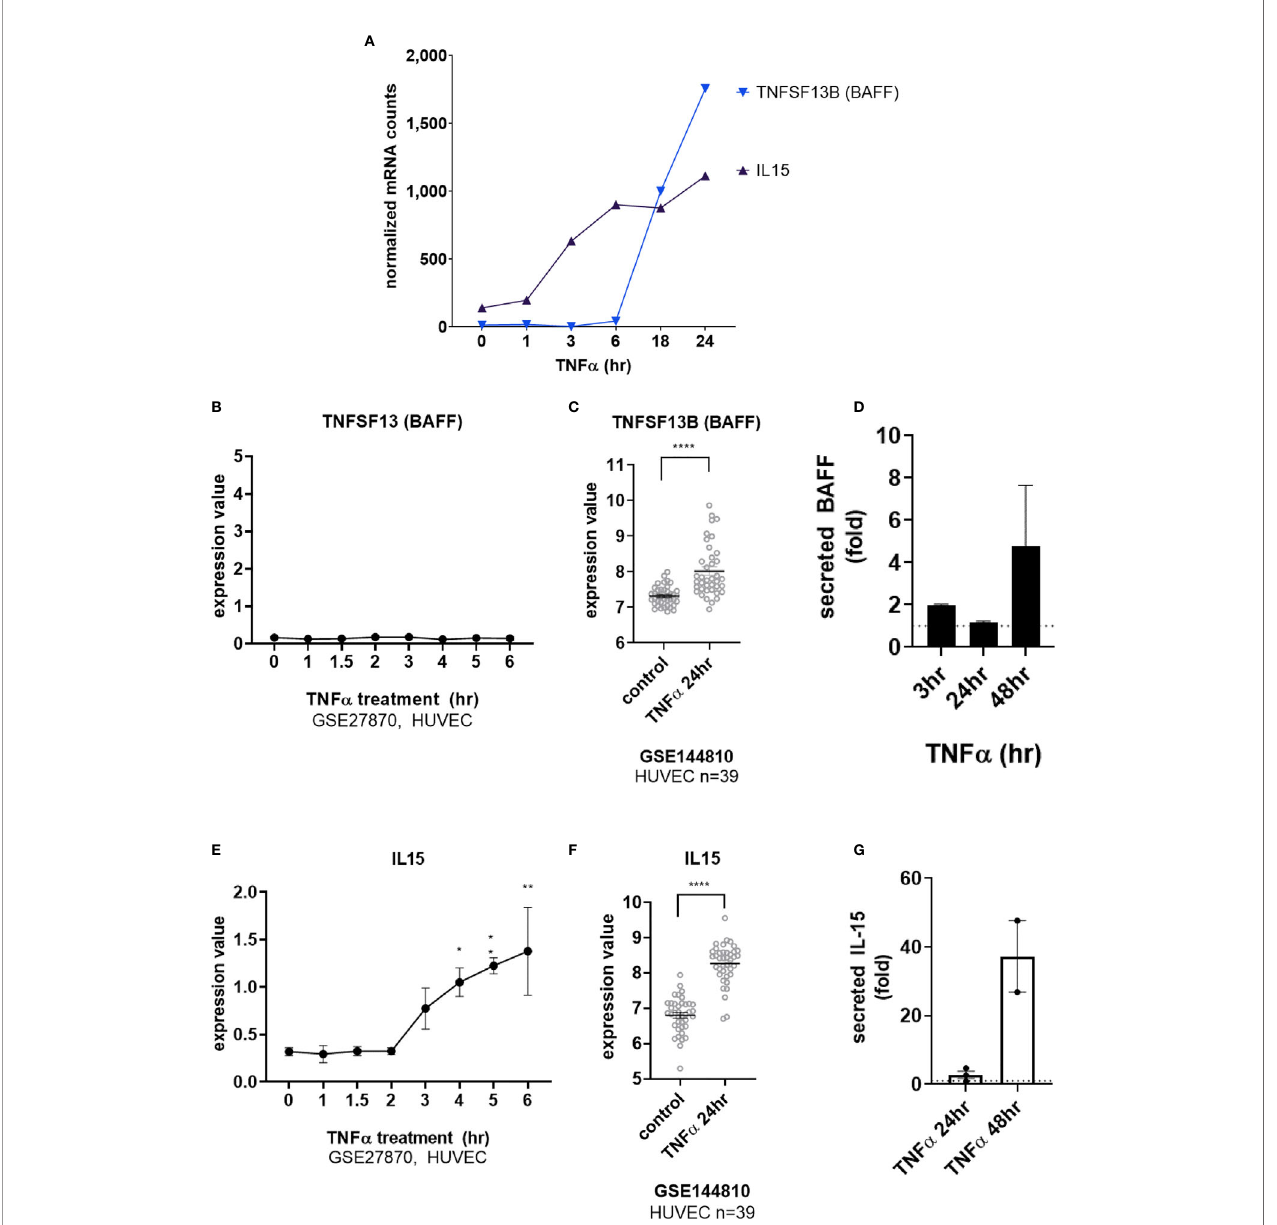
FIGURE 4 | TNF a induces endothelial expression of cytokines IL-15 and BAFF/BLyS. (A) HMEC-1 endothelial cells were stimulated with TNF a (20ng/mL) for 1hr, 3hr, 6hr, 18hr or 24hr. Time course of TNF a late phase induced cytokine mRNA for TNFSF13B and IL15 a in HMEC-1. One representative experiment is shown. Results are presented as absolute number of normalized mRNA counts for each gene, normalized to housekeeping controls. (B) Expression values of TNFSF13 from GSE27870 are plotted, for HUVEC stimulated with TNF a for 1hr, 1.5hr, 2hr, 3hr, 4hr, 5hr and 6hr. Values at each time point were compared to baseline (0hr) by One way ANOVA followed by uncorrected Fisher ’ s LSD t test. Results are shown as mean ± SEM (n=3). (C) Expression values of TNFSF13B from GSE144810 are plotted, comparing HUVEC (n=39) left untreated or stimulated with TNF a for 24hr. Value distributions were compared by unpaired t test. Results are presented with each measured value, and the line at the median. ****p < 0.0001. (D) Primary human aortic endothelial cells (n=4 HAEC donors) were stimulated with TNF a for 3hr, 24hr or 48hr. Supernatants were collected and secreted BAFF protein was measured by ELISA. Results are presented as the fold increase in secreted cytokine compared with conditioned medium from untreated endothelial cells, mean ± SEM. (E) Expression values of IL15 from GSE27870 are plotted, for HUVEC stimulated with TNF a for 1hr, 1.5hr, 2hr, 3hr, 4hr, 5hr and 6hr. Values at each time point were compared to baseline (0hr) by One way ANOVA followed by uncorrected Fisher ’ s LSD t test. *p < 0.05; **p < 0.01. Results are shown as mean ± SEM (n=3). (F) Expression values of IL15 from GSE144810 are plotted, comparing HUVEC (n=39) left untreated or stimulated with TNF a for 24hr. Value distributions were compared by unpaired t test. Results are presented with each measured value, and the line at the median. ****p < 0.0001. (G) Primary human aortic endothelial cells (n=2 donors) were stimulated with TNF a for 24hr or 48hr. Supernatants were collected and secreted IL-15 protein was measured by ELISA. Results are presented as the fold increase in secreted cytokine compared with conditioned medium from untreated endothelial cells, mean ±